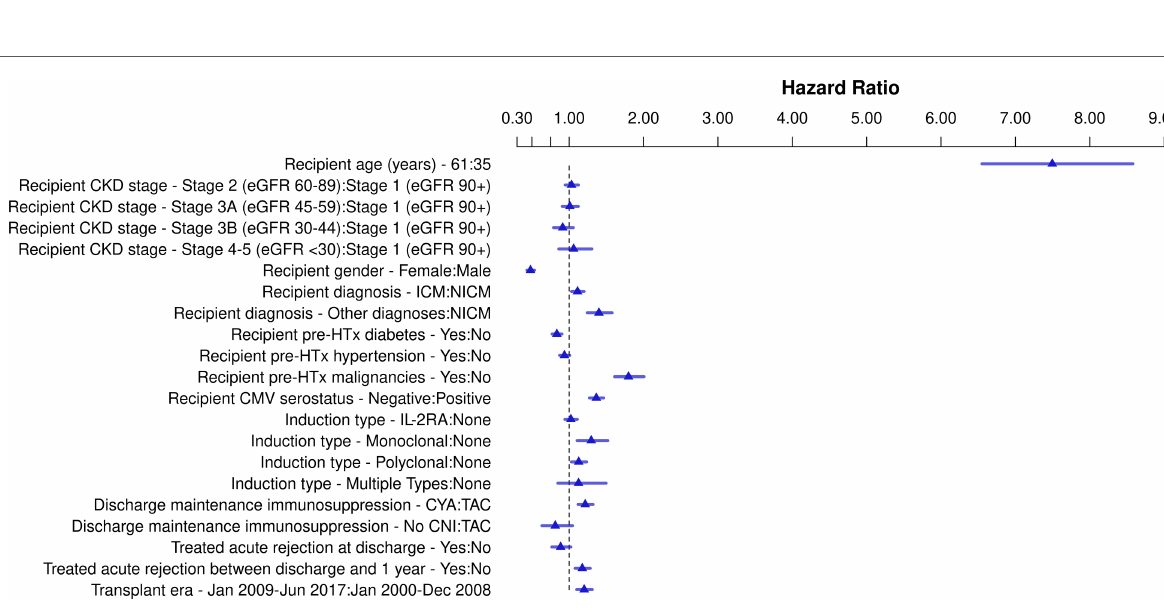
FIGURE 5 Schematic overview of risk factors for skin malignancies post-heart transplant. Hazard ratios for continuous variables are shown for the third quartile vs. the fi rst quartile. Abbreviations: CKD, chronic kidney disease; CMV, cytomegalovirus; CYA, cyclosporine; eGFR, estimated glomerular fi ltration rate; HTx, heart transplantation; ICM, ischemic cardiomyopathy; IL-2RA, interleukin-2 receptor antagonist; NICM, non-ischemic cardiomyopathy; TAC,